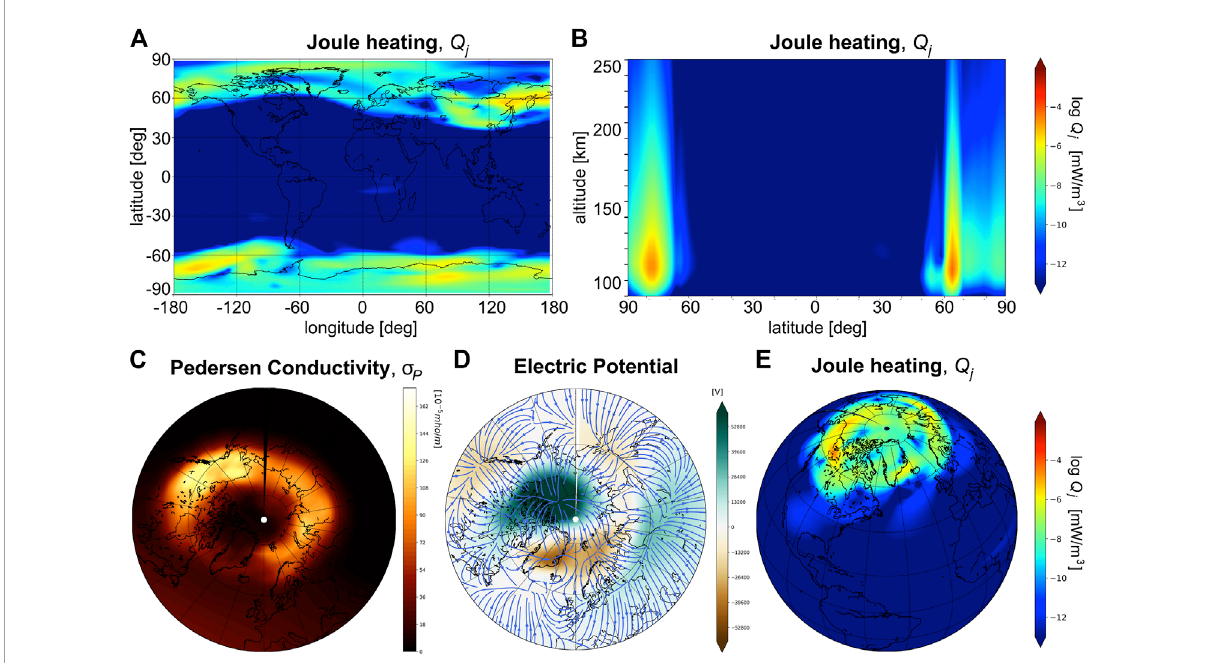
FIGURE 3 (A) 2D latitude-longitude map of Joule heating rate at 120 km. (B) Altitude-latitude plot of Joule heating rate along a meridional cut at fixed longitude. (C) Polar plot (north) of Pedersen Conductivity at 120 km, (D) Polar plot (north) of electric potential with overlaid streamlines of electric field, at 120 km. (E) Orthographic global plot of Joule heating at 120 km. All plots correspond to the peak of St. Patrick’s day storm, 17 March 2015, 13:55